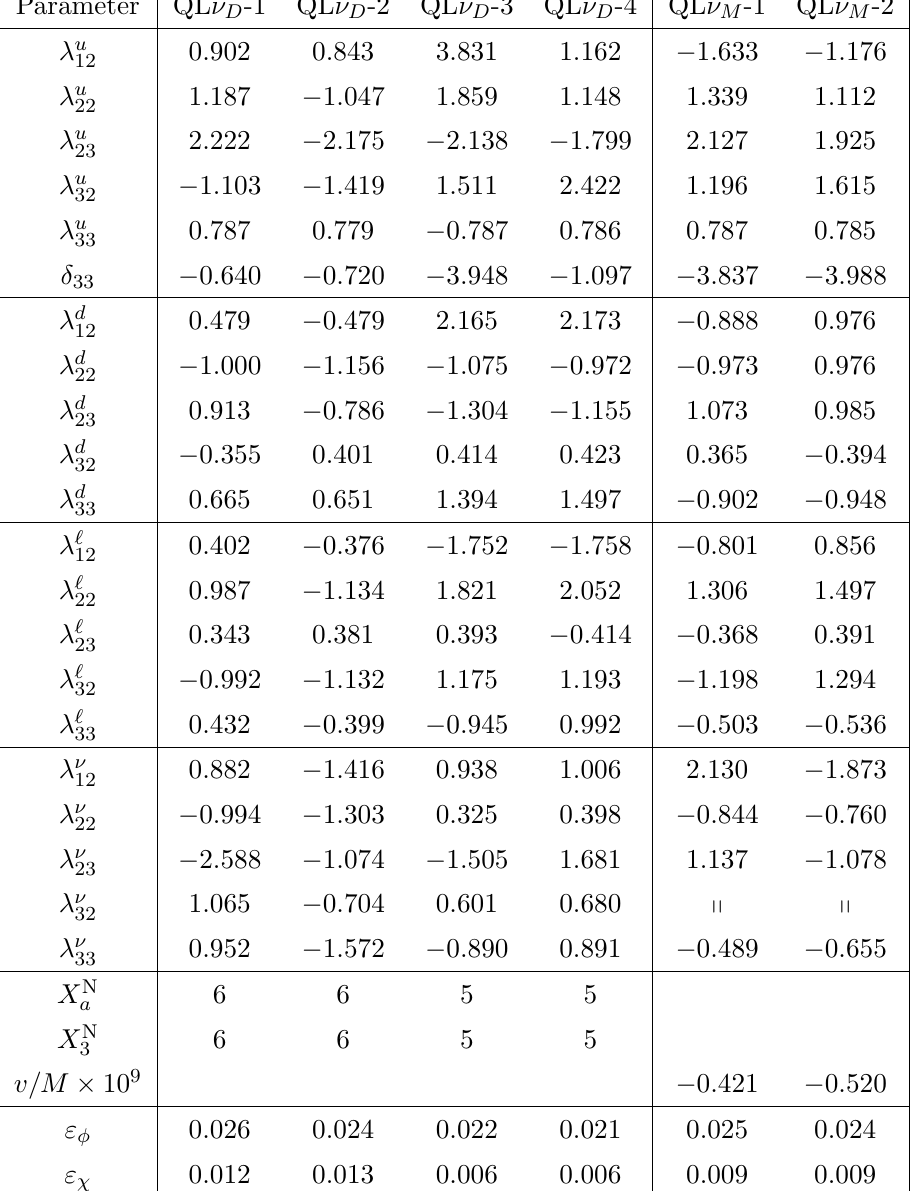
Table 15 . Fit parameters for Dirac (SU(2) (cid:2) U(1) Model) and Majorana neutrinos ( D 6 (cid:2)